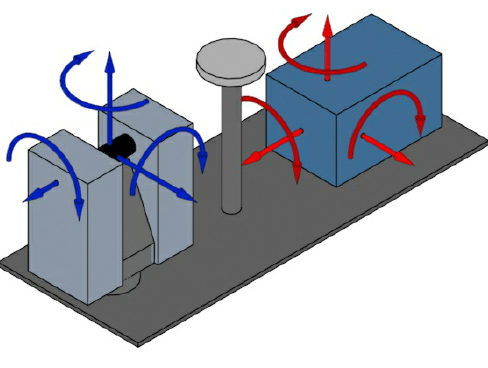
laser scanner and the inertial measurement unit (IMU) sensor. The coordinate system of the IMU is drawn in red and defines the body coordinate system of the platform. The location of the blue laser scanner coordinate system must be known in the red